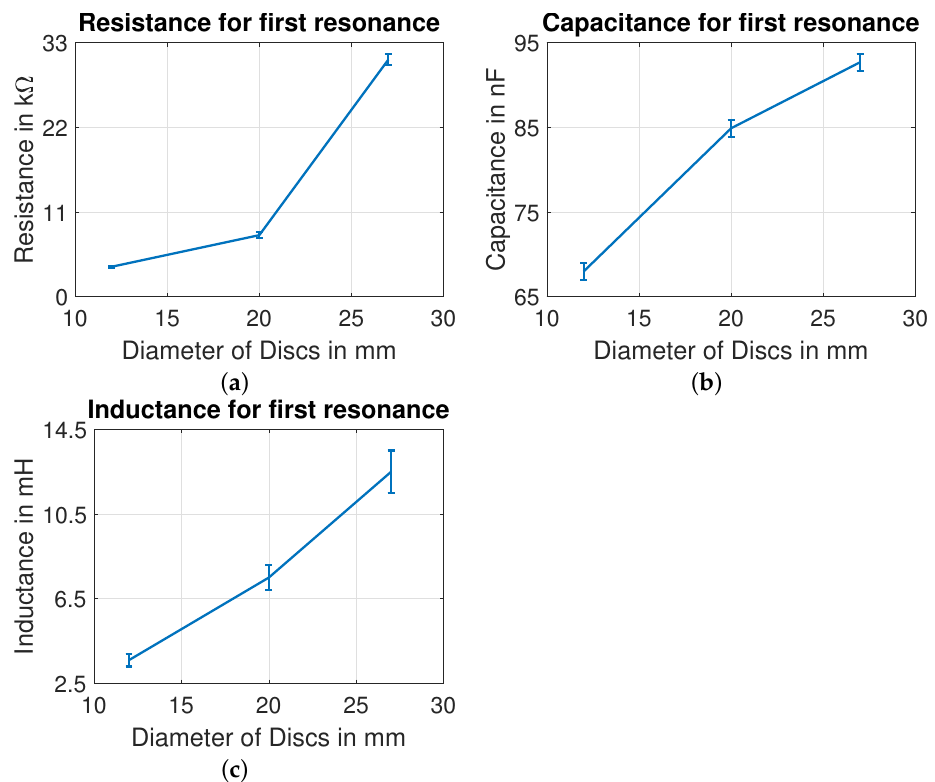
Figure 17. Influence of diameter on ( a ) resistance, ( b ) capacitance, and ( c ) inductance for first